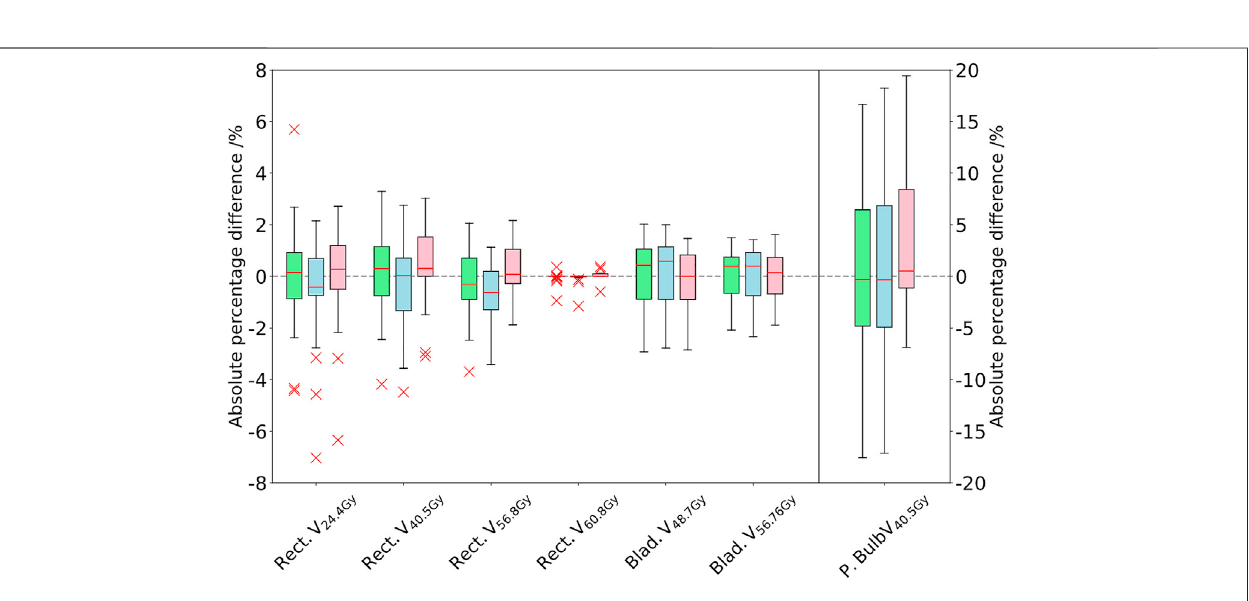
FIGURE 3 | Comparison of the DVH parameters for the rectum, bladder, and penile bulb. The difference between the PSCT (green), PBCT (blue), and AICT (pink) approachestowardthegoldstandardCTisgiveninabsolutepercentagepointsofthestructurevolumebysubtractionoftheGSfromthework fl owmethod.Theboxplot of the penile bulb is scaled on the y -axis of the right